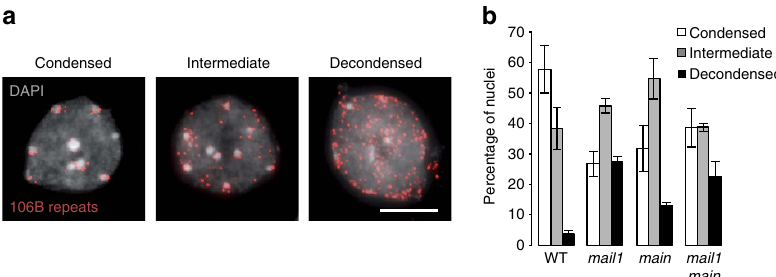
Figure 5 | Condensation of pericentromeric heterochromatin appears impaired in mail1 and main mutants. ( a ) Representative images of the three chromatin condensation states observed in WT leaf interphase nuclei hybridized with a probe for 106B pericentromeric repeats and counterstained with DAPI. Representative images of mutant nuclei hybridized with the same probe are shown in Supplementary Fig. 15. Scale bar, 5 m m. ( b ) Proportions of nuclei belonging to each class of nuclei shown in a based on the degree of condensation of the 106B fluorescent signal in the indicated genotypes. About 100–220 nuclei were scored per genotype. Values represent means from two biological replicates ± maximum and